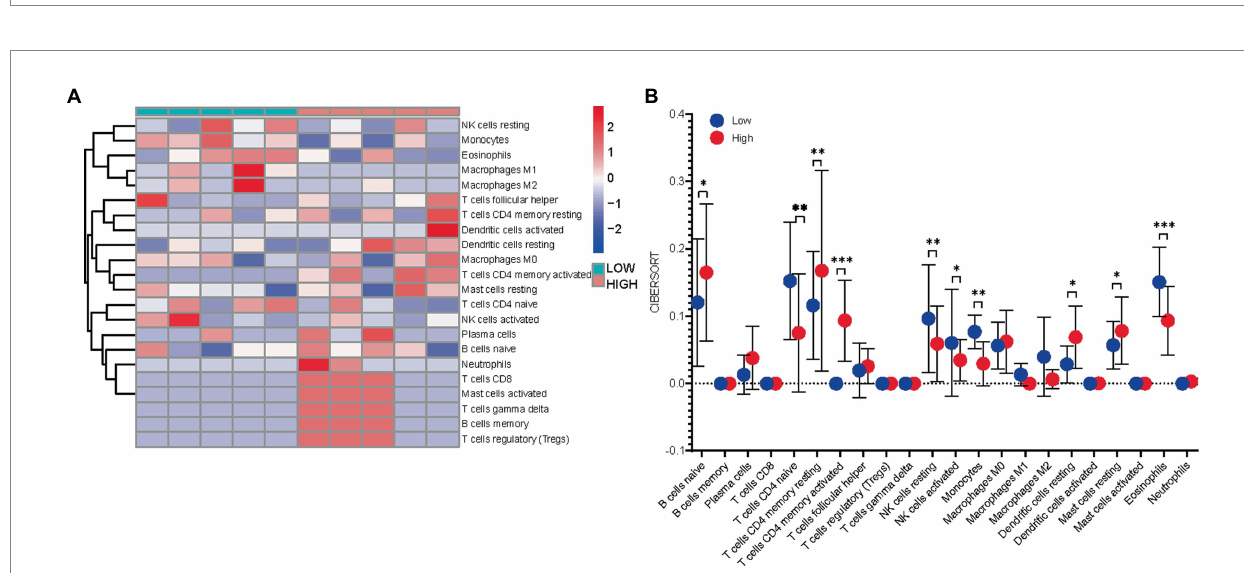
FIGURE 6 Immuno-correlation of IL2 in neuropathic pain. (A) Relative distribution of 22 kinds of immune cells in all neuropathic pain samples. (B) The difference of immune cell infiltration between high -and low-expression IL2